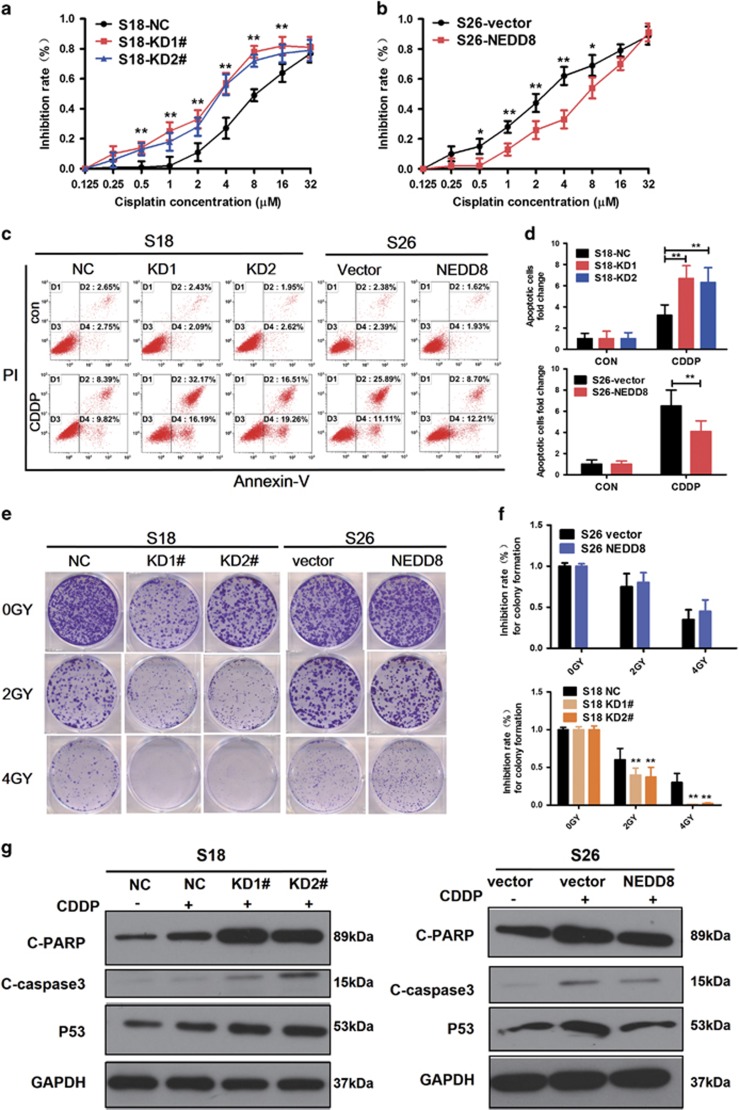
NEDD8 induces the sensitivity of cisplatin and radiation in NPC cells. (a,b) S18 cells with silenced NEDD8 and S26 cells with overexpressed NEDD8 were seeded in 96-well plates at a density of 1 × 103 per well and treated different concentrations cisplatin (CDDP) as indicated for 72 h. Cell viabilities were tested by the MTT assay. (c,d) The cells were seeded in 6-well plates at a density of 1 × 105 per well and treated with 8 μM CDDP for 48 h. The apoptosis rates were detected with the Annexin-V/PI kit and analyzed by flow cytometry. (e,f) The cells were treated with different GY of radiation. Representative images (e) and the inhibition rate of colonies formed (f) are shown. (g) Western blotting analysis of cleaved PARP, cleaved-caspase-3 and p53. Three independent experiments were performed for each assay. The quantified results were presented as the means±S.E.M. (n=3). *P<0.05, **P<0.01